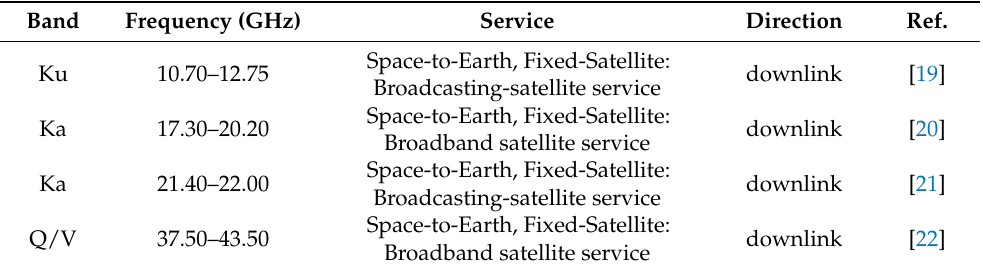
Table 1. Frequency bands for the downlink of communication satellites above 10 GHz (ITU Region 1).